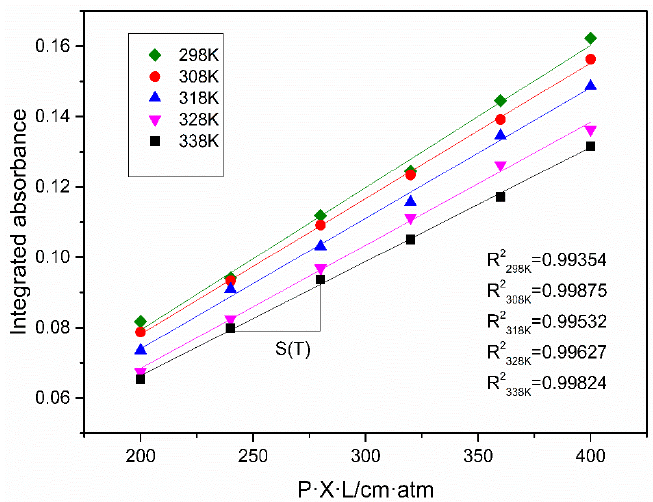
Figure 7. Integrated absorbance as a function of P ⋅ X ⋅ L (T = 298–338 K, P = 1 atm). Table 2. Line intensity (10 − 4 cm − 2 ·atm − 1 ) values from database and calculated values.